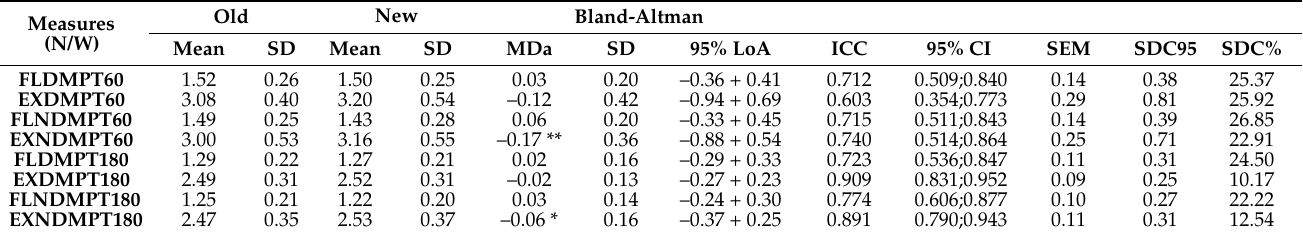
Table 6. Inter-rater reliability of trial 2.